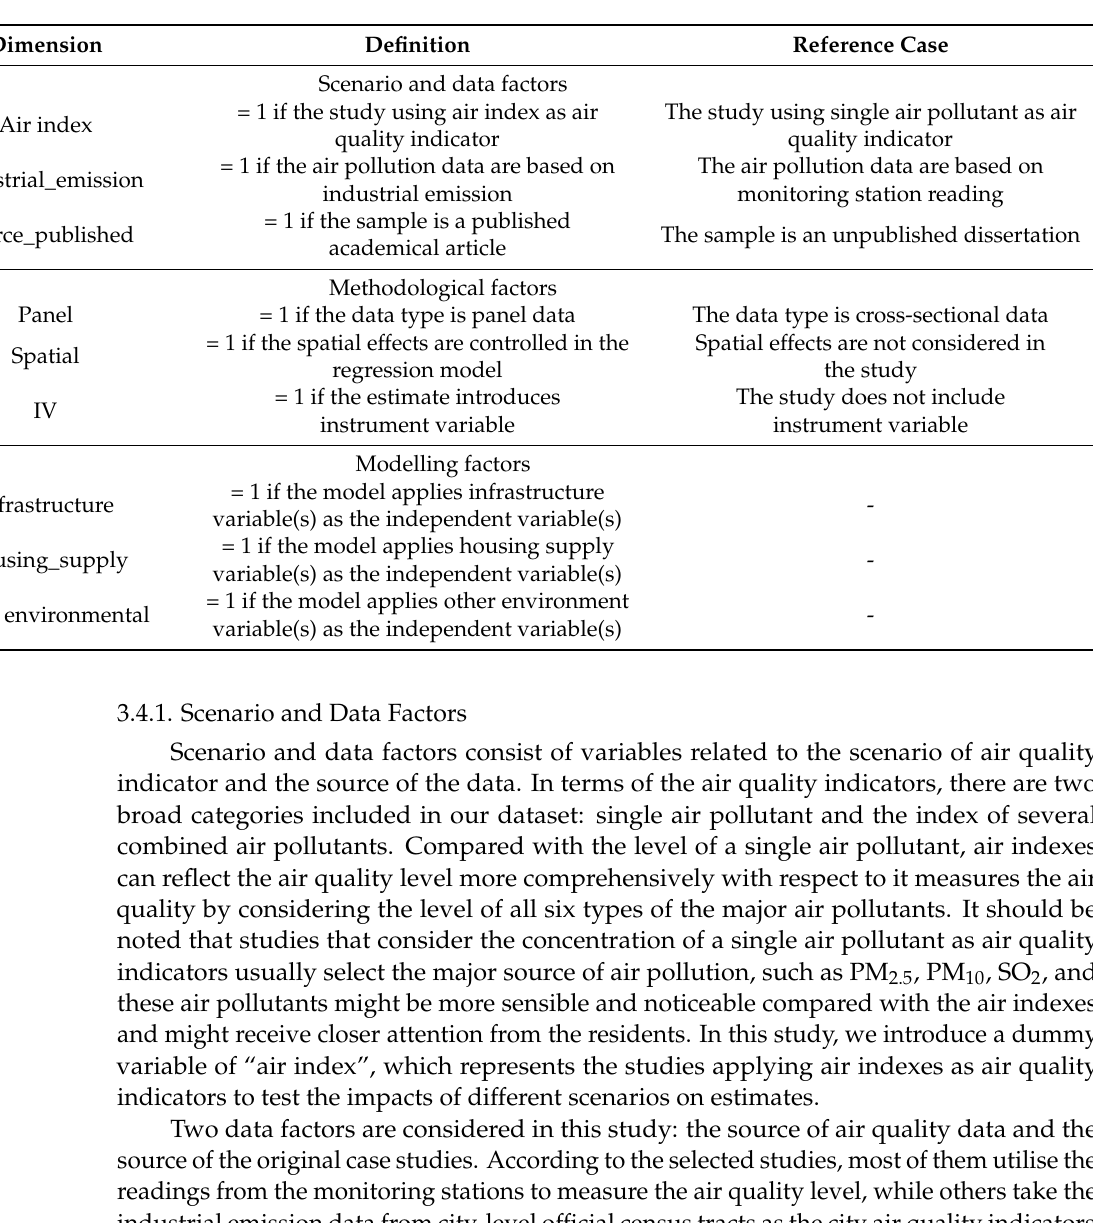
Table 4. The definition of